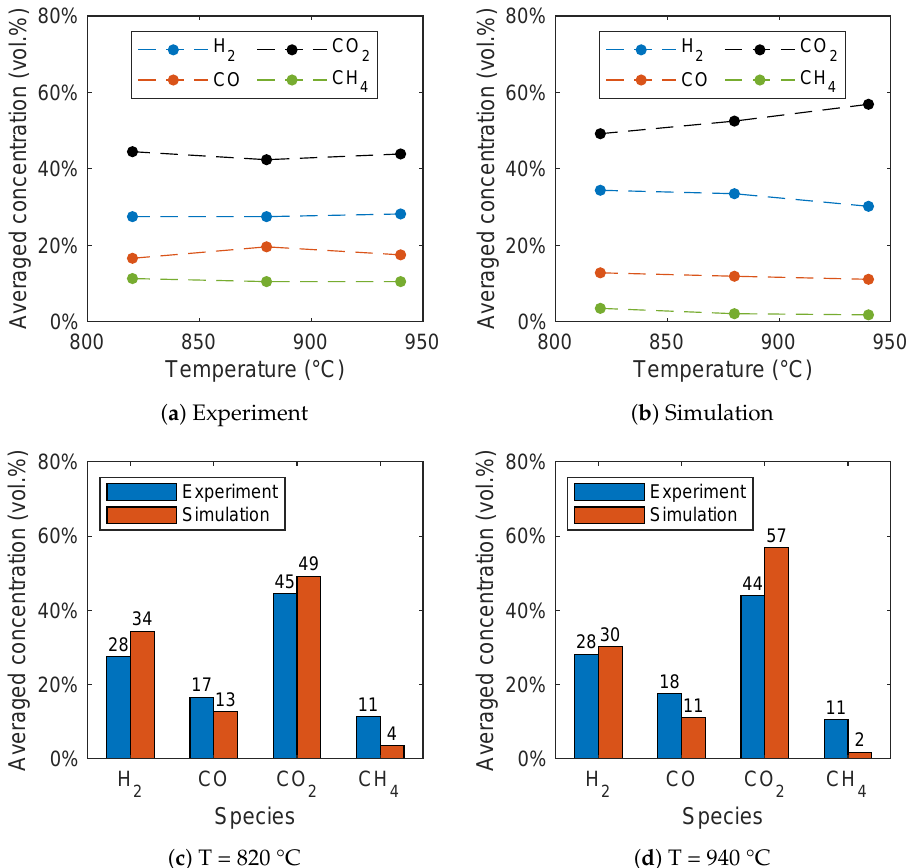
Figure 16. Influence of the temperature on the syngas composition for ( a ) the experimental data given by Condori et al. [5] and ( b ) the simulation results. Comparison of the syngas composition for ( c ) 820 °C and ( d ) 940